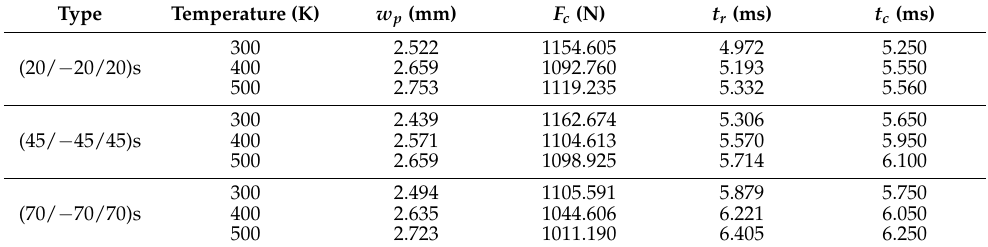
Table 8. Low-velocity impact response of the sandwich structure with various temperatures.